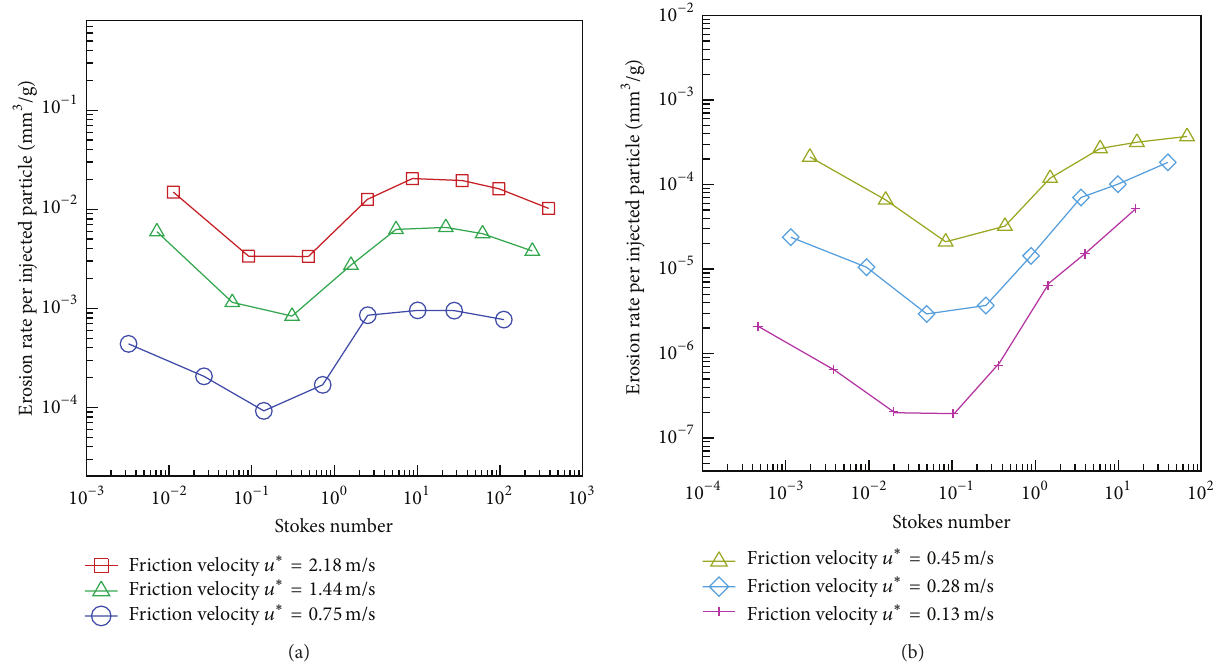
Figure 3: Comparison of the erosion rate 𝐸 V per injected particle against the particle diameter and inlet flow velocity: (a) larger inlet velocities of 15, 33, and 52 m/s and (b) smaller inlet velocities of 2.2, 5.3, and